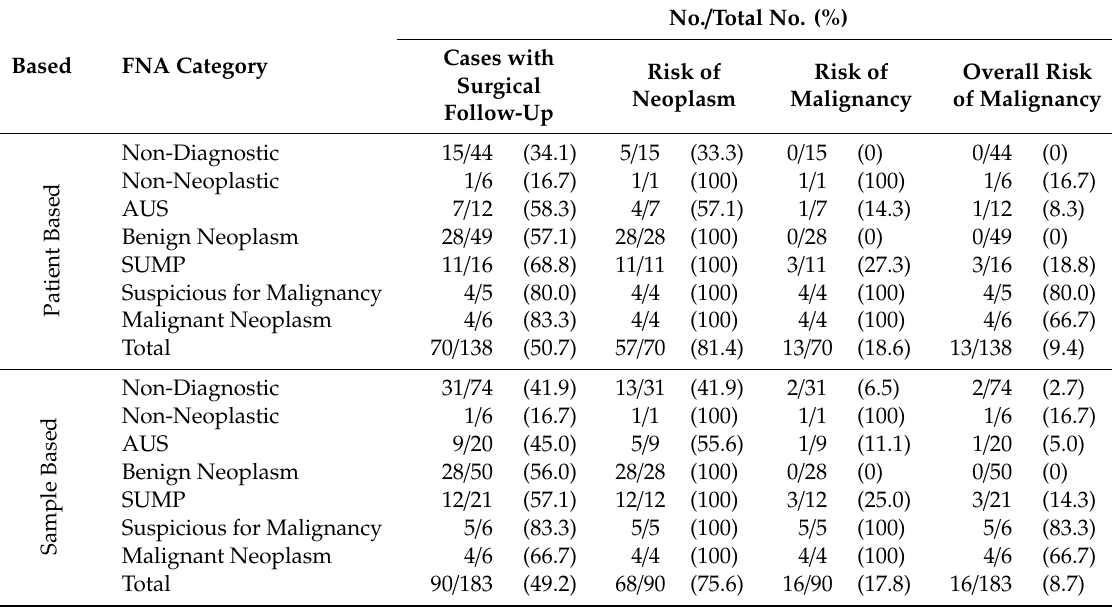
Table 3. Diagnoses According to MSRSGC, Patient and Sample